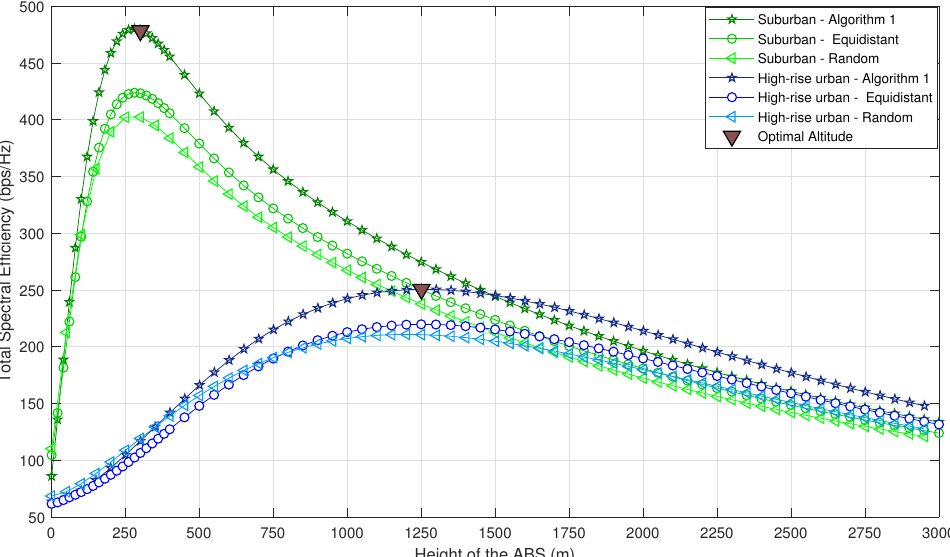
Figure 7. Total spectral efficiency vs. altitude of the ABS (comparing Algorithm 1-based deployment, random deployment, and equidistant